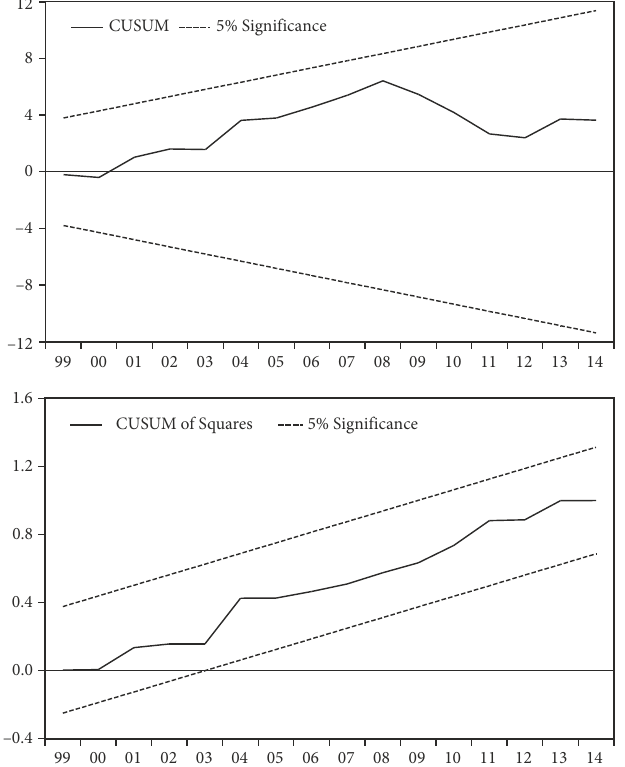
Figure 8. CUSUM and CUSUM squared tests (source: authors’ own